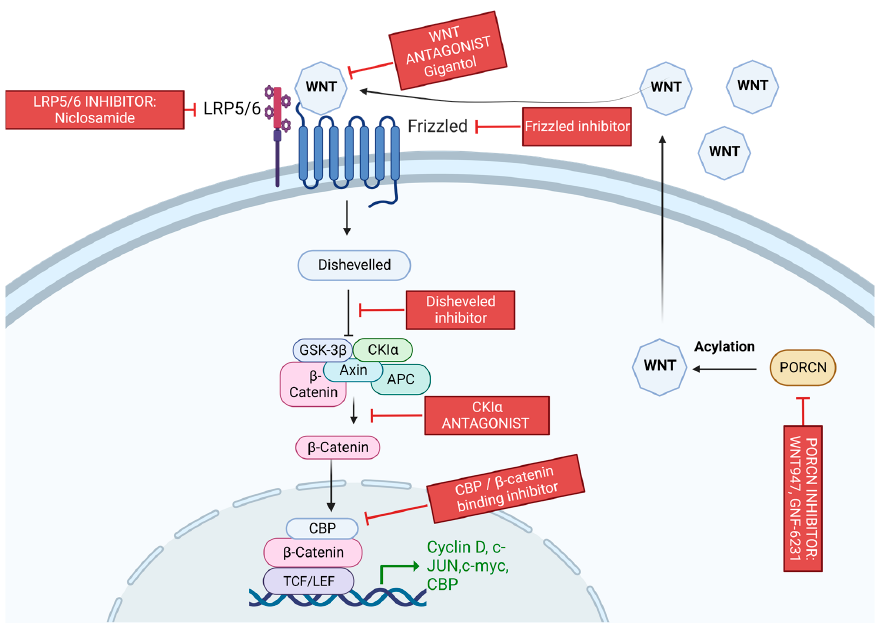
Figure 8. A diagram of the Wnt signaling pathway. The binding of Wnt to its receptors Frizzled and LRP5/6 inhibits the degradation of β -catenin, which regulates the expression of many genes. Receptor activation leads to the recruitment of the disheveled protein (Dvl). Dvl is then activated via phosphorylation, inducing the dissociation of GSK-3 β from axin and causing GSK-3 β to be deactivated. The deactivation of GSK-3 β inhibits the degradation of β -catenin, allowing it to translocate into the nucleus. The nodes at which current therapies target the pathway are included as well. Created with